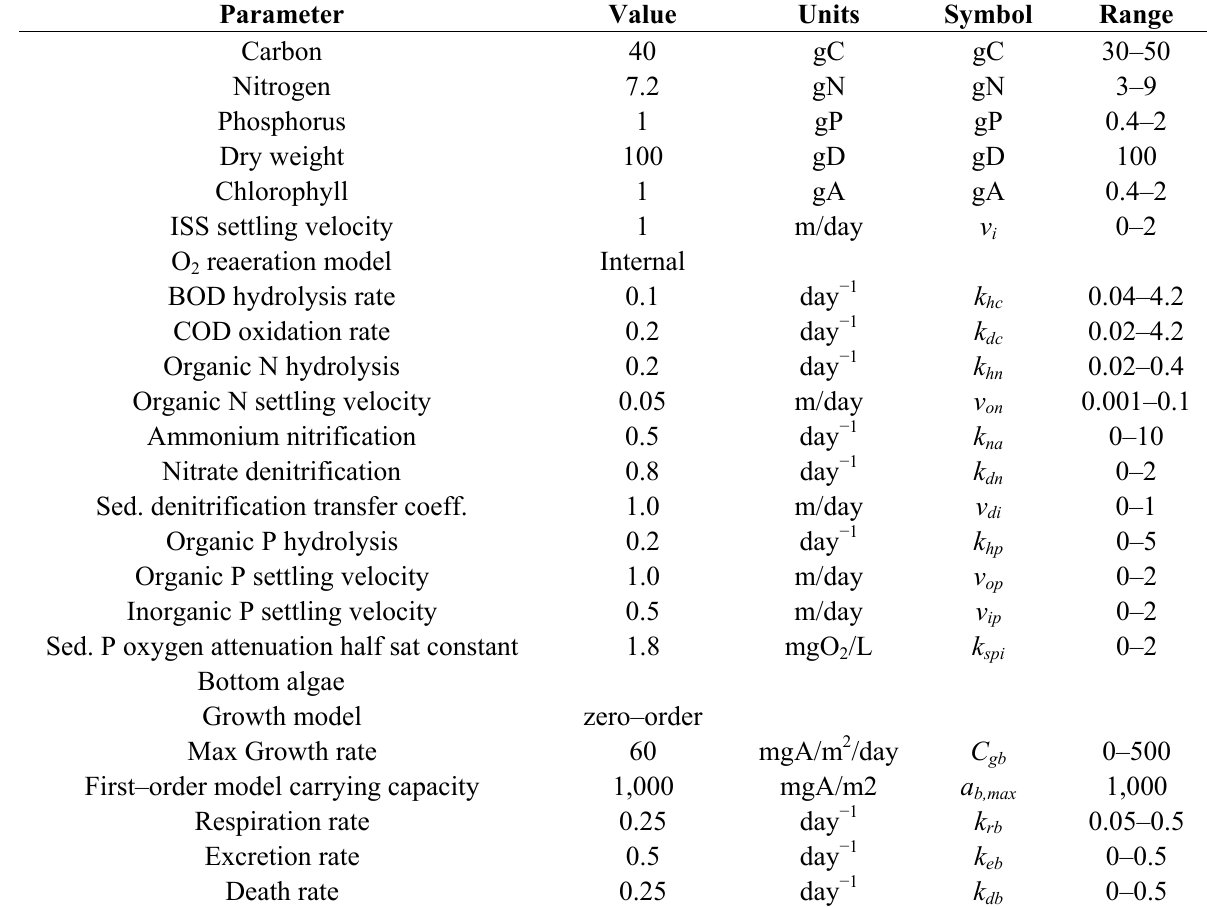
Table 7. Calibrated parameters for simulating the water quality of Hongqi